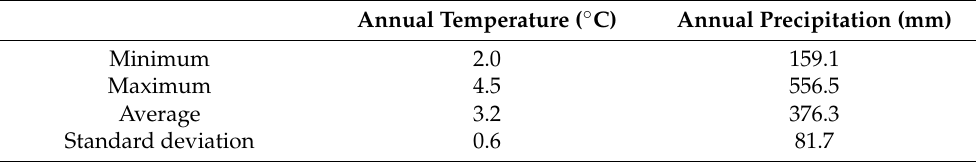
Figure 2. Interannual and seasonal variations of precipitation and temperature at the Nagarze station from 1974 to 2019. Table 1. Statistics of meteorological data from 1974 to 2019 at the Nagarze weather